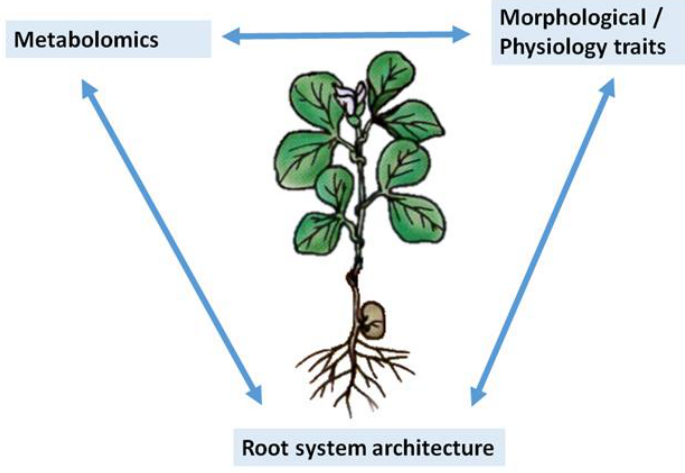
Figure 2. The key elements of the roadmap and how these relate to one another.